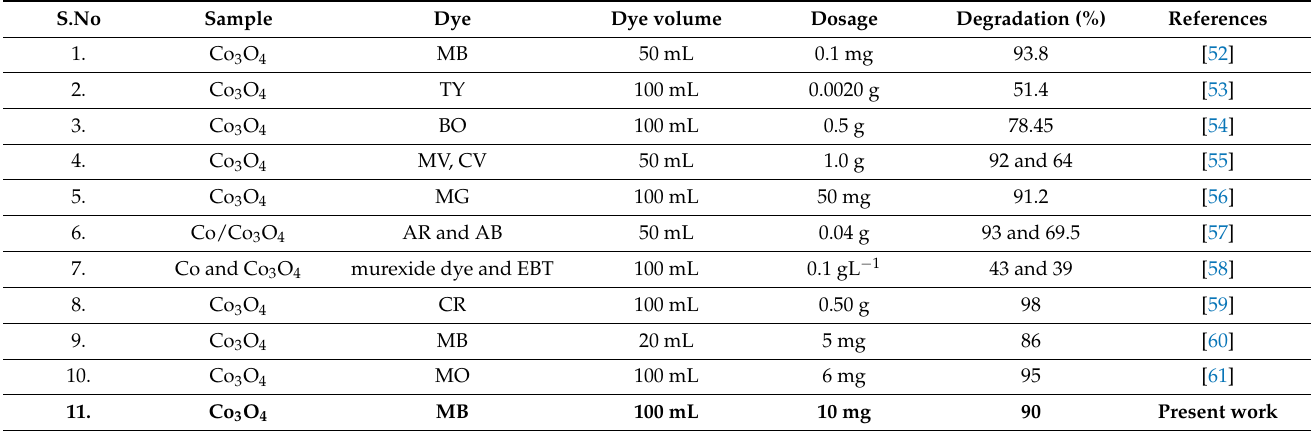
Table 1. Comparison table of Co 3 O 4 nanoparticles degradation against different